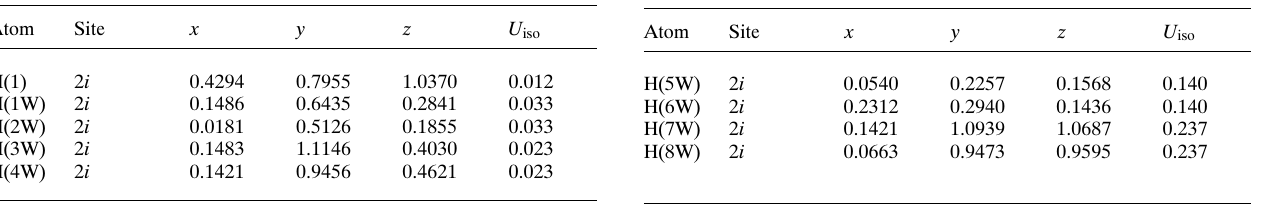
Table 2. Atomic coordinates and displacement parameters (in Å 2 )